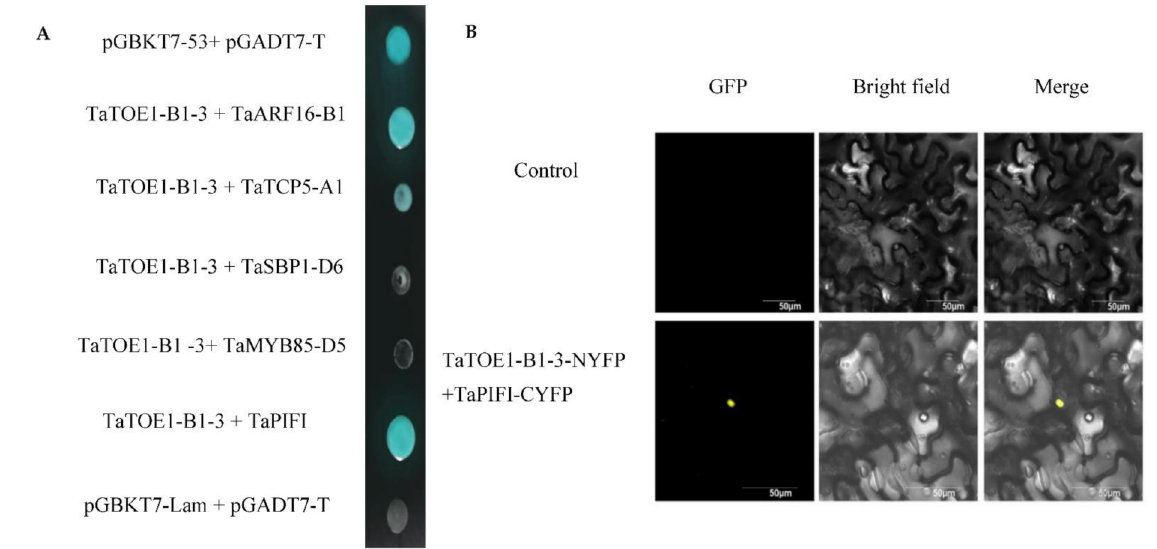
Figure 7. Supplementary validation of TaTOE1-B1-3 interacting with candidate proteins. ( A ) Yeast point-to-point detection; ( B ) BiFC detection (bar = 50 µ